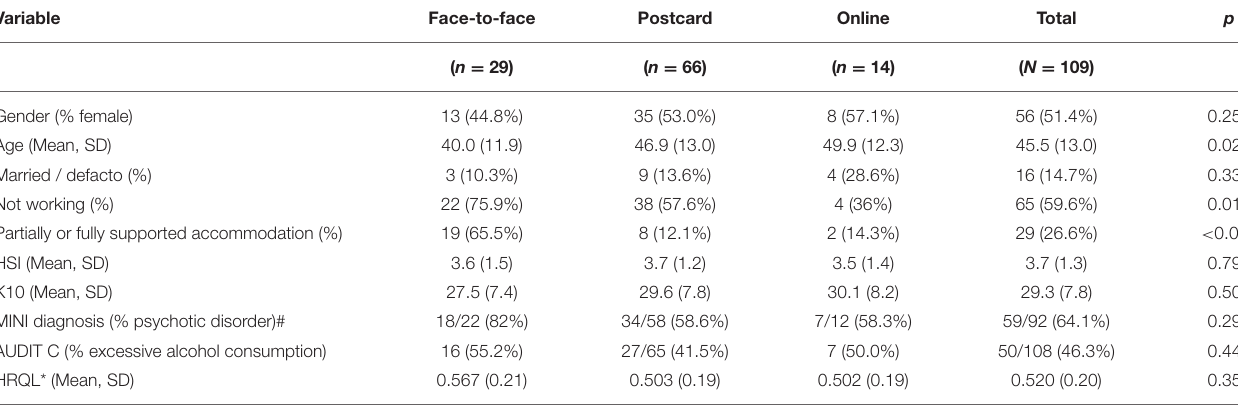
TABLE 1 | Participant characteristics by recruitment strategies.